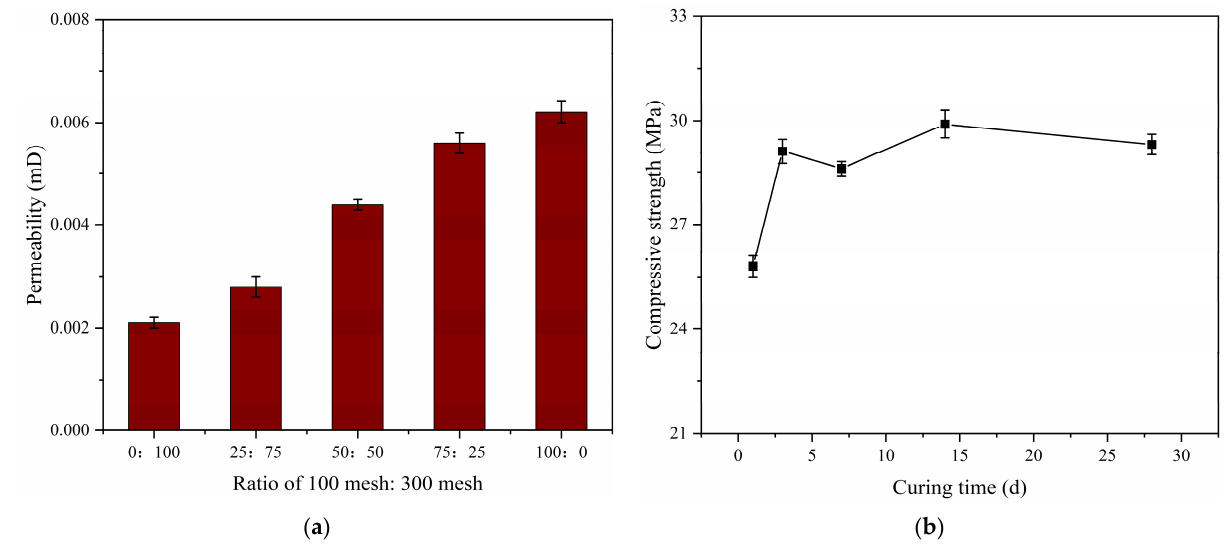
Figure 5. Performances of mixed silica fume cement slurry.( a ) Permeability; ( b ) Compressive strength.